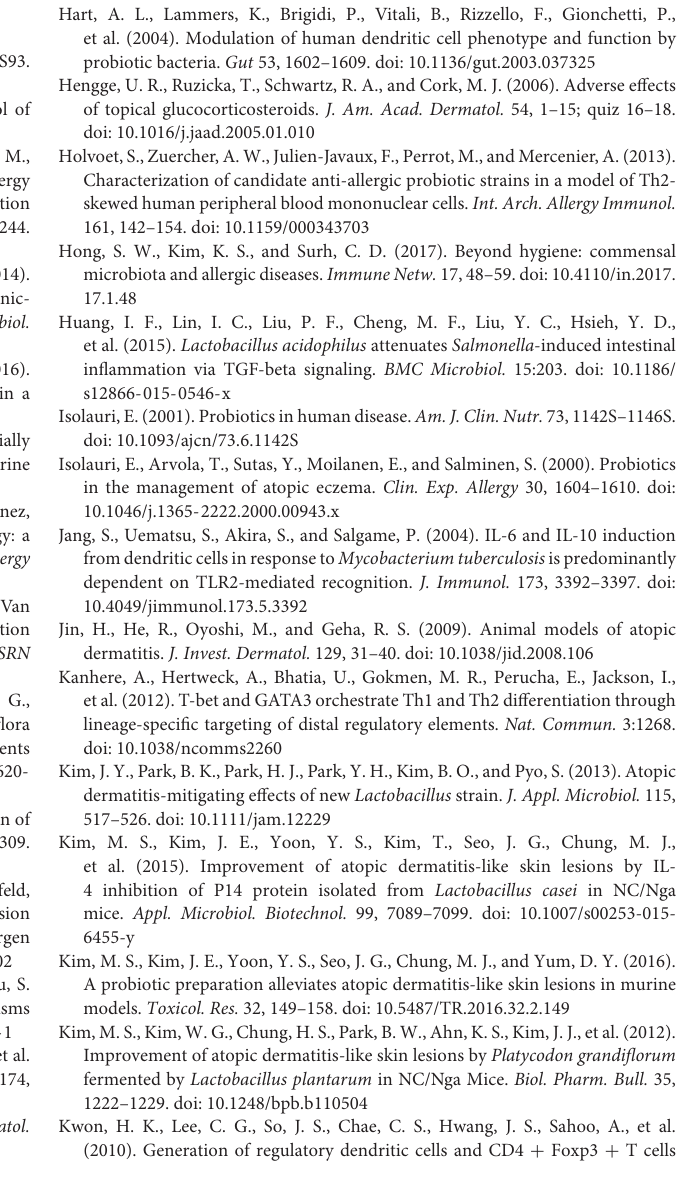
FIGURE S2 | Apoptosis of BMDCs treated with probiotics that comprise Duolac ATP. BMDCs were treated with various concentrations of probiotics [Duolac ATP, Bifidobacterium lactis (BL), Lactobacillus casei (LC), Lactobacillus plantarum (LP), or Lactobacillus rhamnosus (LR)] for 24 h. The percentage of apoptotic cells, Shown as the annexin V-positive fraction, was measured. The concentration of BMDCs was 2 × 10 5 cells in all groups. Data are representative of at least three experiments. FIGURE S3 | Expression of surface molecules on BMDCs treated with Duolac ATP. BMDCs were treated with LPS or 2 × 10 6 CFU of Duolac ATP for 24 h. The ratios of CD86-, MHC II-, and PD-L1-expressing cells in BMDCs were measured by flow cytometry. Data are representative of at least three experiments. ∗ P < 0.05, ∗∗∗ P < 0.001 using one-way ANOVA with Tukey’s multiple comparison test. Bars indicate mean ± SEM. FIGURE S4 | Body and spleen weight changes in the AD mouse model treated with Duolac ATP. Atopic dermatitis was induced by exposing mice to HDM extracts for 3 weeks; mice were then administered Duolac ATP for 4 weeks. (A)